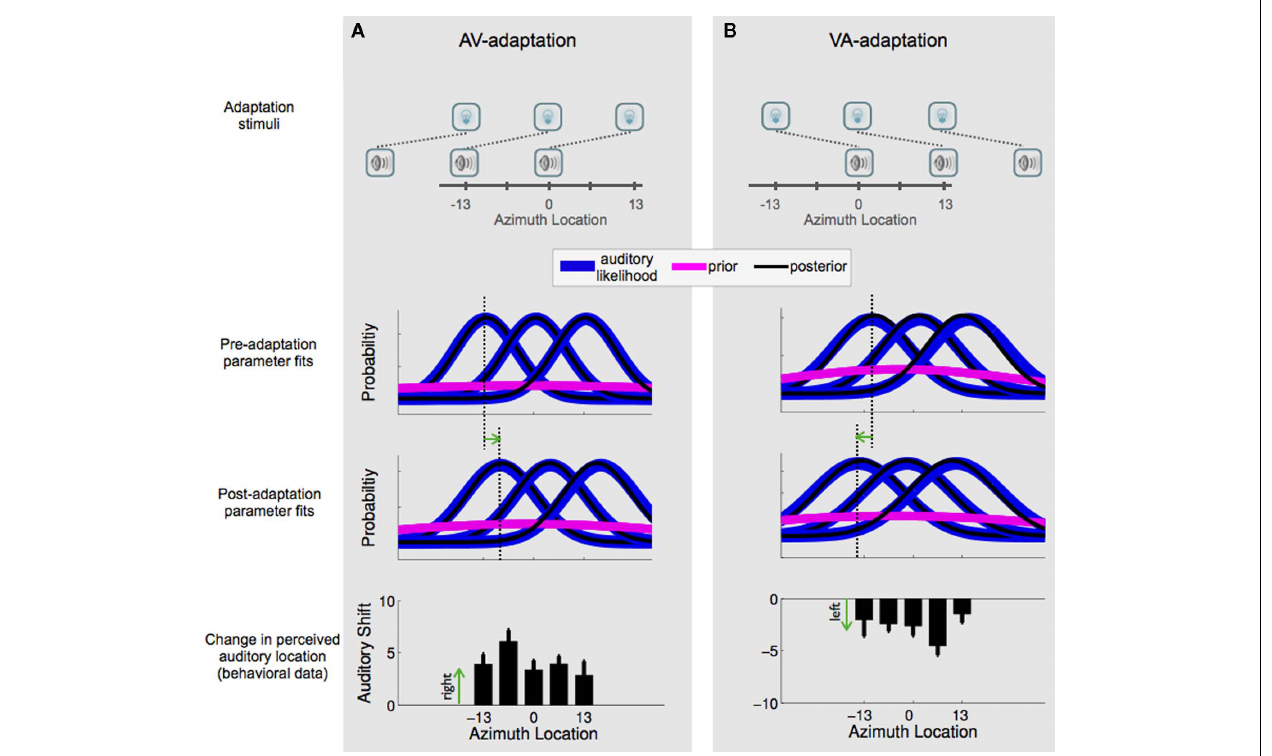
Table 1 .The dashed lines highlight the mean of the likelihood distribution at one of the spatial locations (chosen arbitrarily for illustration purpose) before and after adaptation, and the green arrow shows the direction of shift in the auditory likelihood.The bottom row shows the actual aftereffects (mean ± SEM) measured from subject responses in the auditory alone